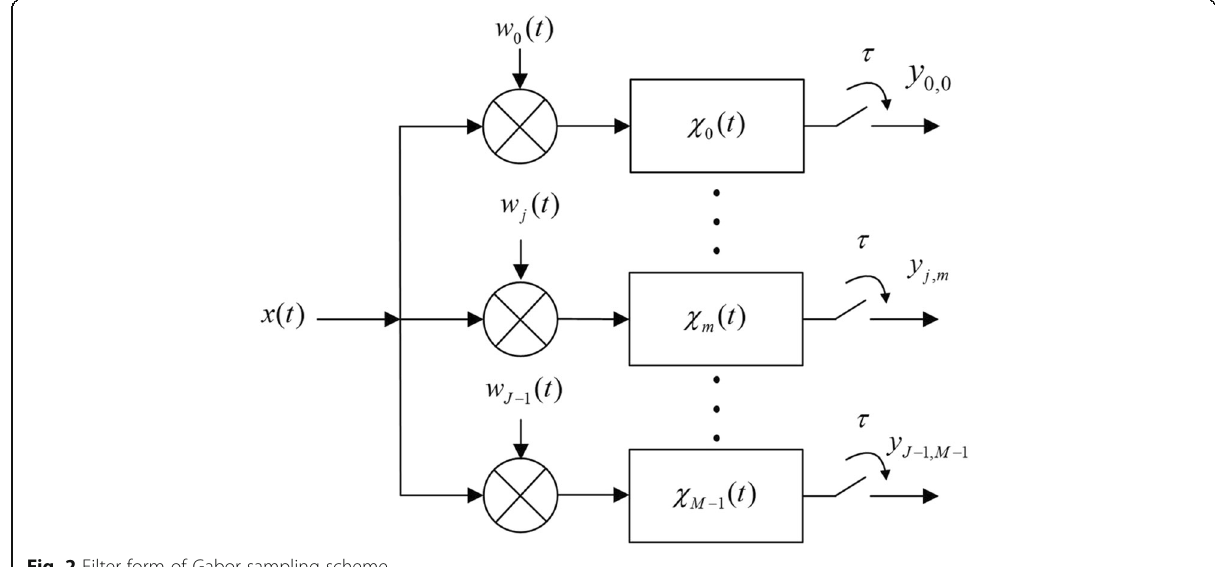
Fig. 2 Filter form of Gabor sampling